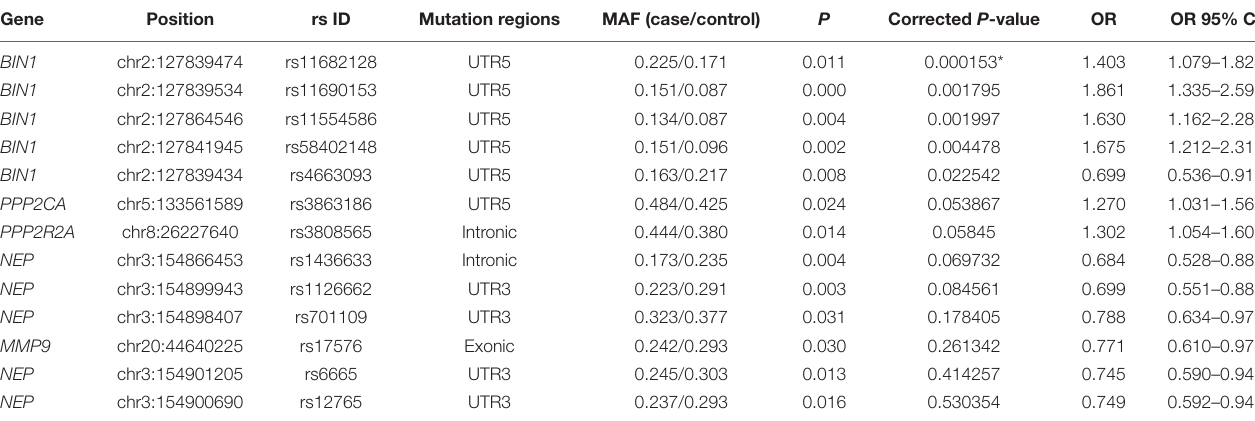
TABLE 2 | Nominally significant common variants between sLOAD and cognitively healthy individuals. Gene Position rs ID Mutation regions MAF (case/control) P Corrected P -value OR OR 95%